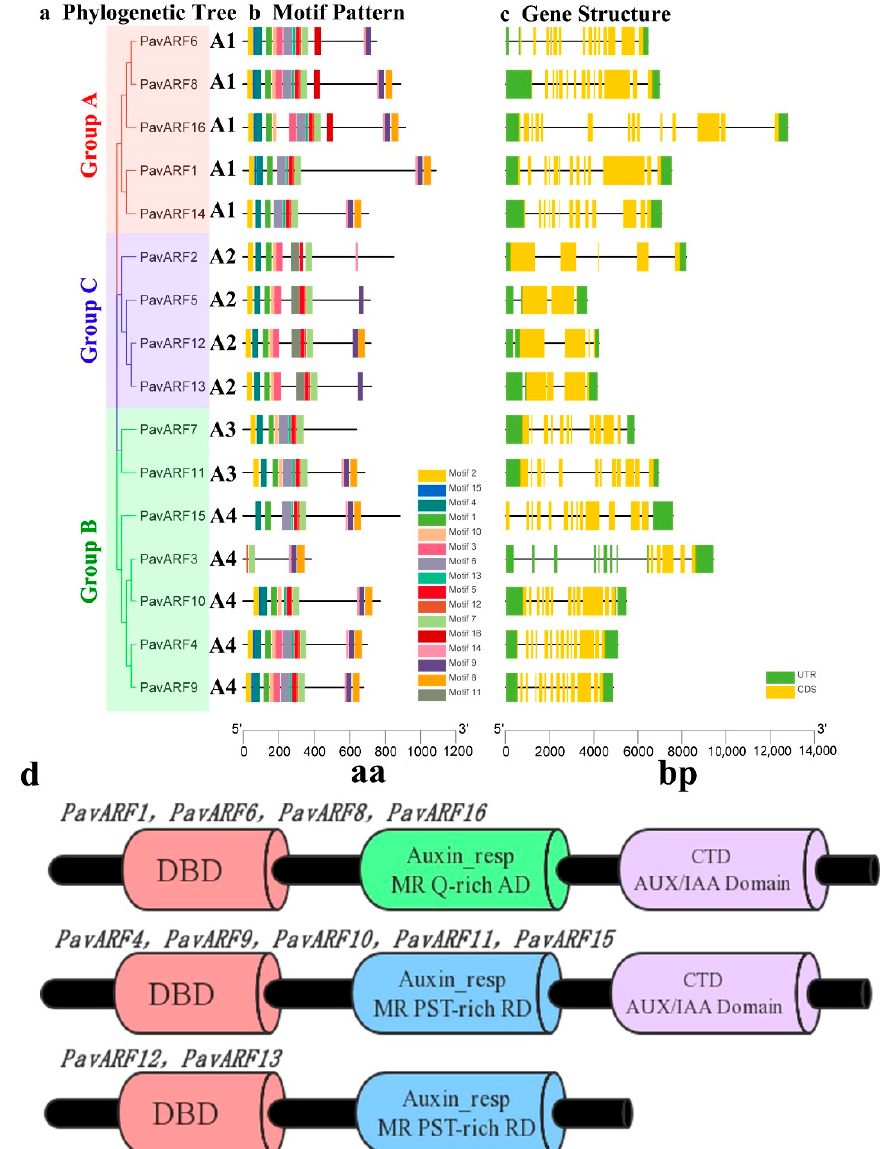
Figure 2. The structure distribution patterns of 16 PavARF genes. ( a ). PavARF phylogenetic tree, clustered into three Group (Group A, B and C). ( b ). The discovered conserved motifs of PavARF proteins. 16 Motifs were found and illustrated by a different color. ( c ). Exon-intron structures of PavARF genes. Exons and introns are shown as yellow color and black lines. The left and right end ware untranslated regions and illustrated by green color. ( d ). The transcriptional activator or transcriptional inhibitor of PavARF predicted by DNAMAN.